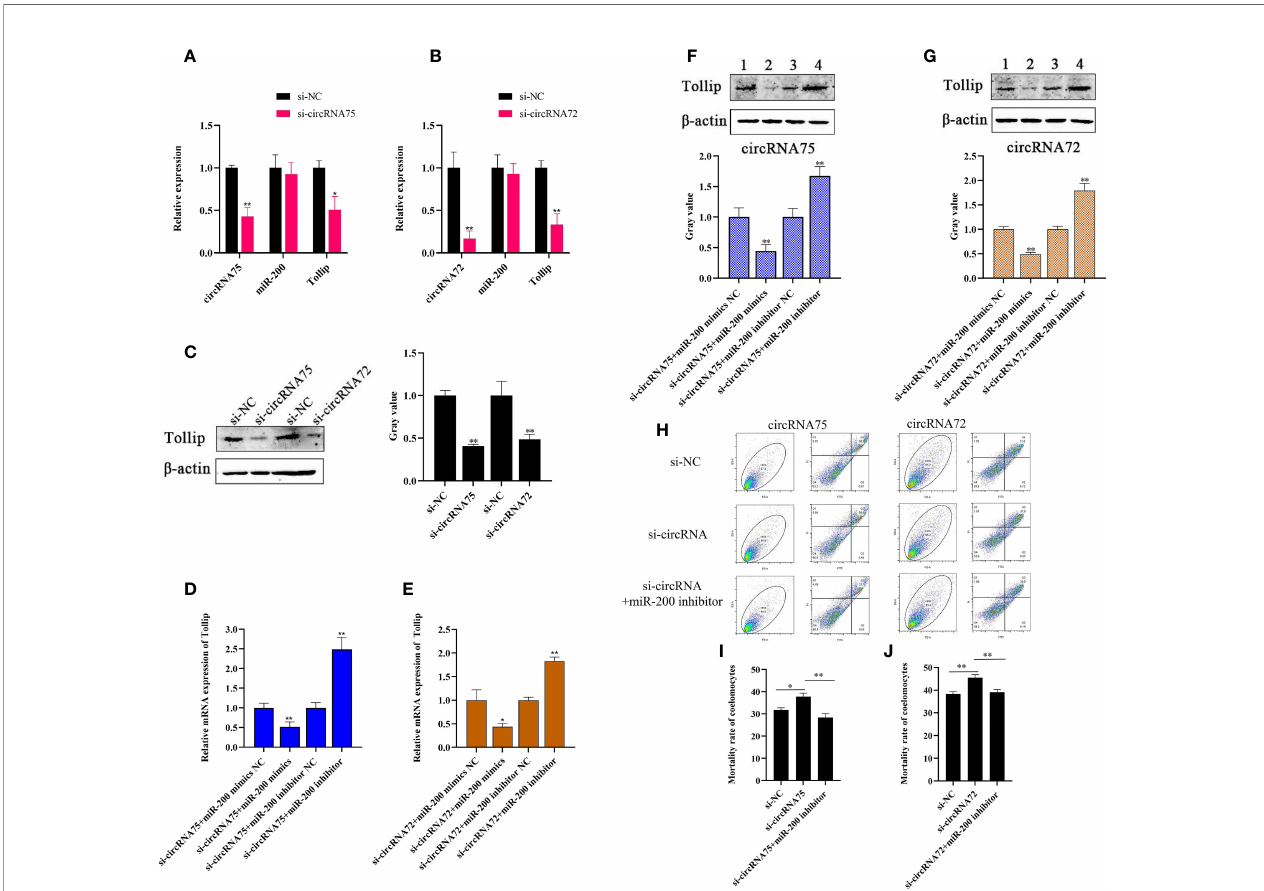
FIGURE 4 | CircRNA75 and circRNA72 could regulate Tollip-mediated coelomocyte apoptosis by sponging miR-200. (A, B) After circRNA75 or circRNA72 knockdown, qRT-PCR detected the regulatory effect on Tollip and miR-200 mRNA levels. (C) After circRNA75 or circRNA72 knockdown, Western blot and gray value analyses detected the regulatory effects on Tollip protein levels. (D, E) Under knockdown conditions of circRNA75 or circRNA72, qRT-PCR detected the effect of miR-200 mimics or inhibitors on the mRNA expression of Tollip. (F, G) Under knockdown conditions of circRNA75 or circRNA72, Western blot and gray value analyses detected the effect of miR-200 mimics or inhibitors on the protein expression of Tollip. (H) Coelomocyte apoptosis assay after circRNA75 or circRNA72 knockdown and in circRNA knockdown after the addition of the miR-200 inhibitor. (I, J) Statistical analysis of apoptosis rate after circRNA75 or circRNA72 knockdown and in the circRNA knockdown of the added miR-200 inhibitor. * p < 0.05 and ** p <